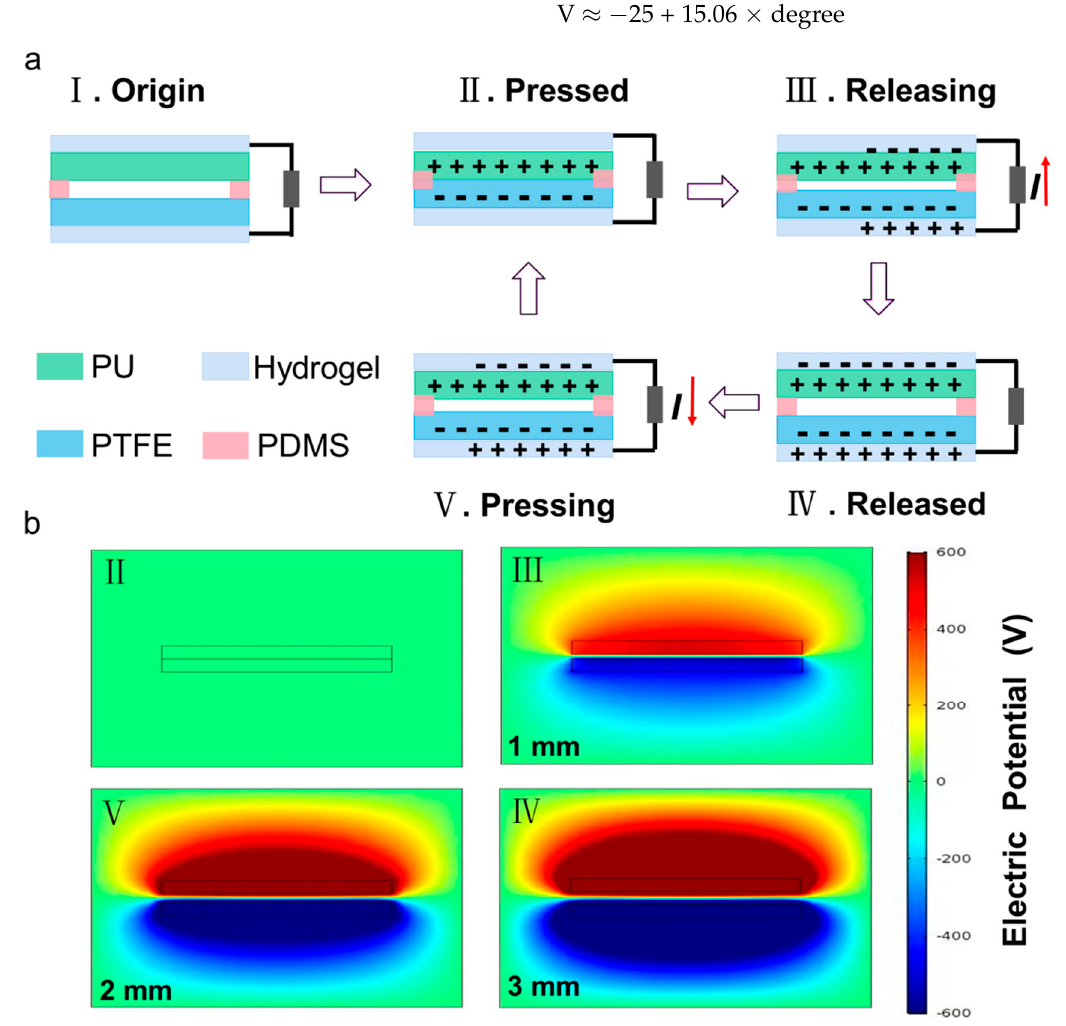
Figure 2. The working mechanism of FL-TENG. ( a ) Schematics of the operating principle for the FL-TENG. (I) The original state of FL-TENG. (II) FL-TENG is compressed. (III) FL-TENG release process. (IV) FL-TENG is released. (V) FL-TENG release process. ( b ) Potential simulations were performed by COMSOL to elucidate the working principle of FL-TENG. (II) FL-TENG compressed potential simulation. (III) FL-TENG release process potential simulation. (IV) FL-TENG is released potential simulation. (V) FL-TENG release process potential